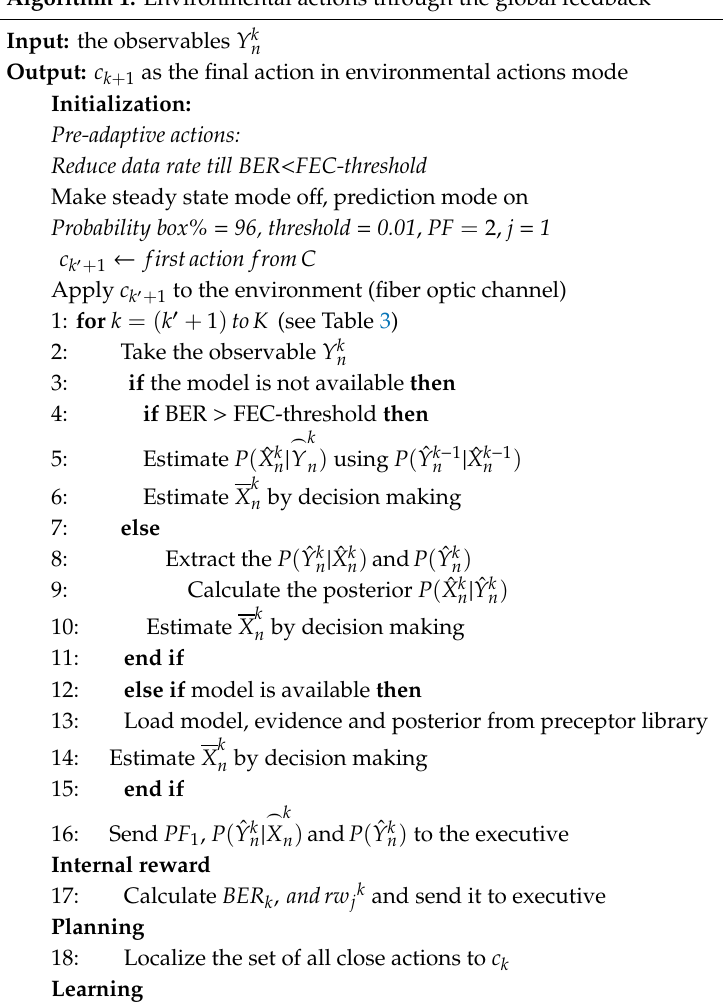
Algorithm 1: Environmental actions through the global